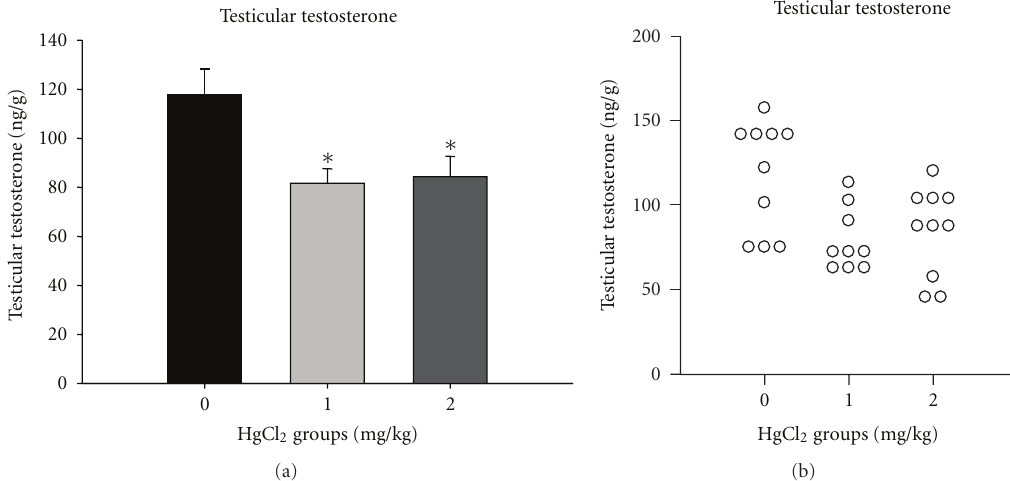
Figure 3: Testicular testosterone levels (a) levels of testes testosterone (ng/gm) for each exposure group. (b) Distribution of testes testosterone for each exposure group. Data are mean and SE. ∗ Represents a significant di ff erence from controls. P < 0 . 05.